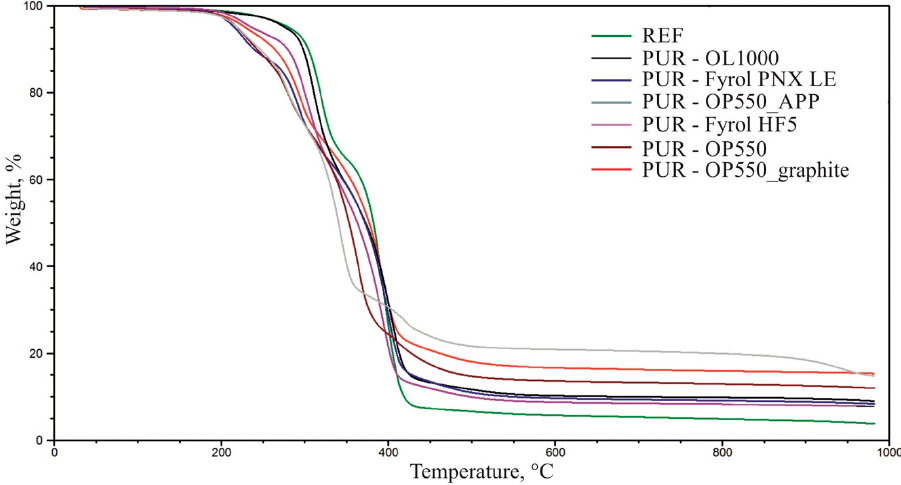
Figure 8. Summary of weight change curves for the foams.